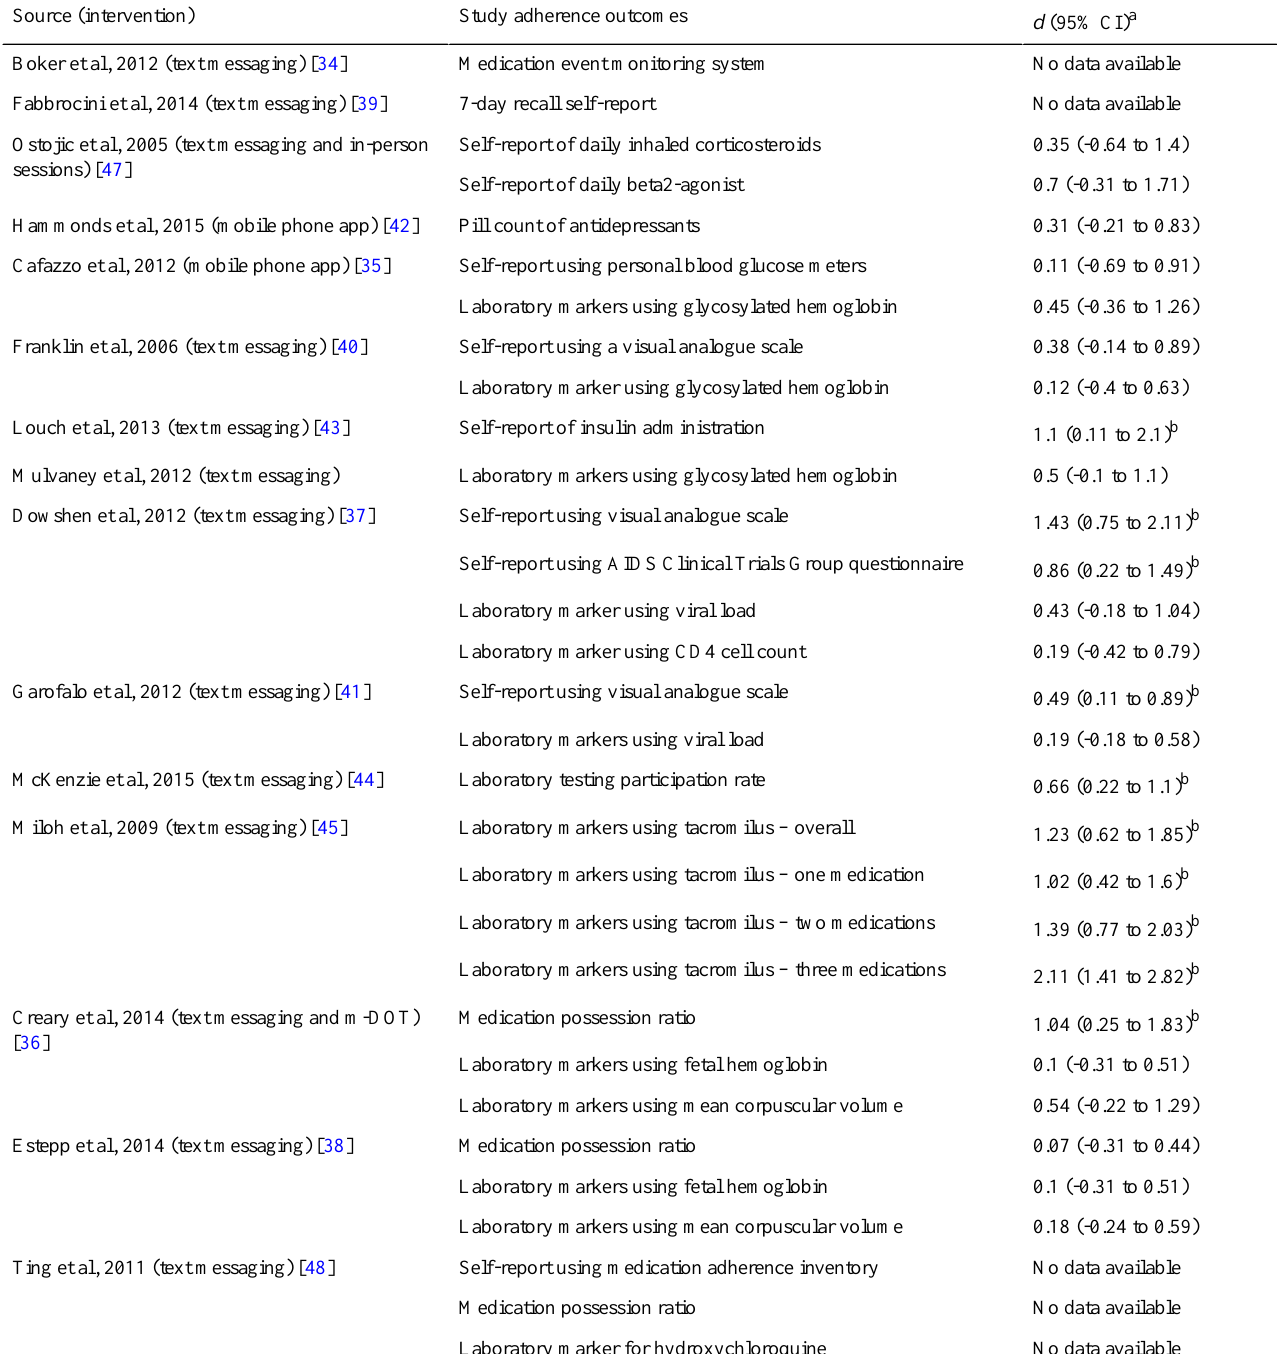
Table 4. Effect size d for the main outcomes of included